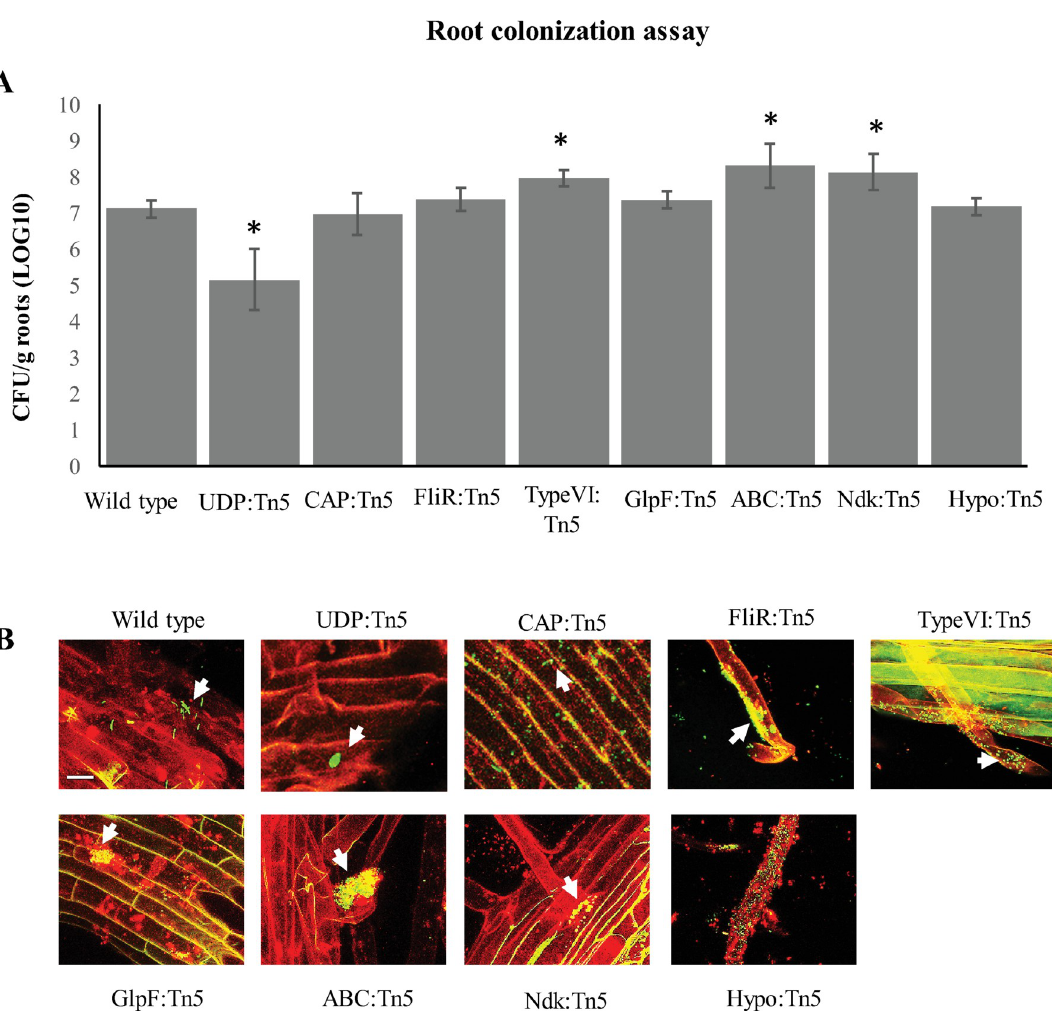
Fig 5. Effects of transposon mutations on root colonization patterns in P . trichocarpa . (A) Colonization of plant roots inoculated with wild type Pantoea YR343, UDP::Tn5, CAP::Tn5, FliR::Tn5, Type VI::Tn5, GlpF::Tn5, ABC::Tn5, Ndk::Tn5, or Hypo::Tn5 mutants and was measured after 3 weeks by counting CFUs relative to the total weight of each plant root. Error bars represent standard deviation over three to five different biological replicates per sample and ( � ) represent statistically significant differences (p < 0.001 for UDP::Tn5 and Type VI::Tn5 compared to the wild type and p = 0.002 for ABC::Tn5 and Ndk::Tn5 compared to the wild type using the student’s t-test. ANOVA analysis indicated statistically significant differences between samples with a p-value below 0.001). (B) Images of P . trichocarpa (red) one week after inoculation with the indicated bacterial strains (green). Scale bar represents 10 μ